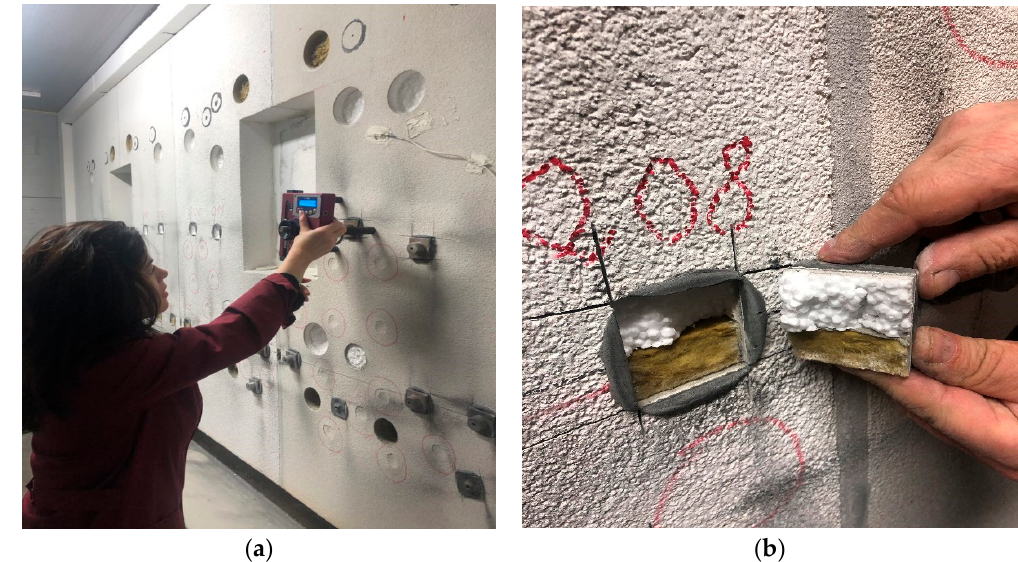
Figure 2. Testing of the bond strength of ETICS: ( a ) testing; ( b ) an example of the typical pull-off at the joint of